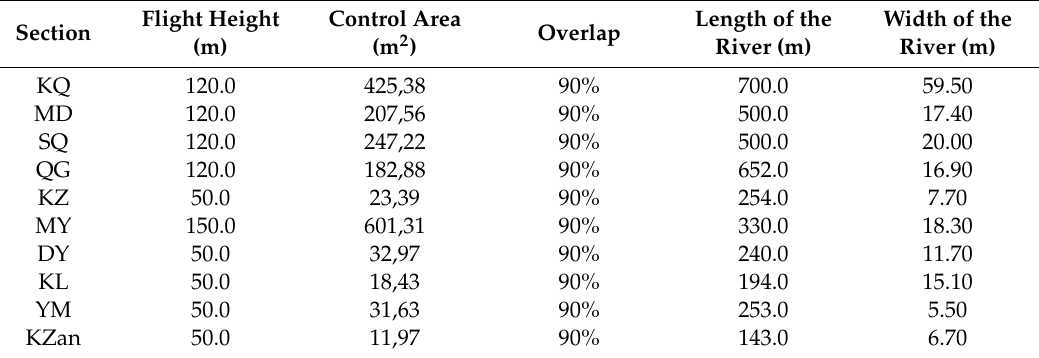
Table 1. Information about the flight control system in different sections.